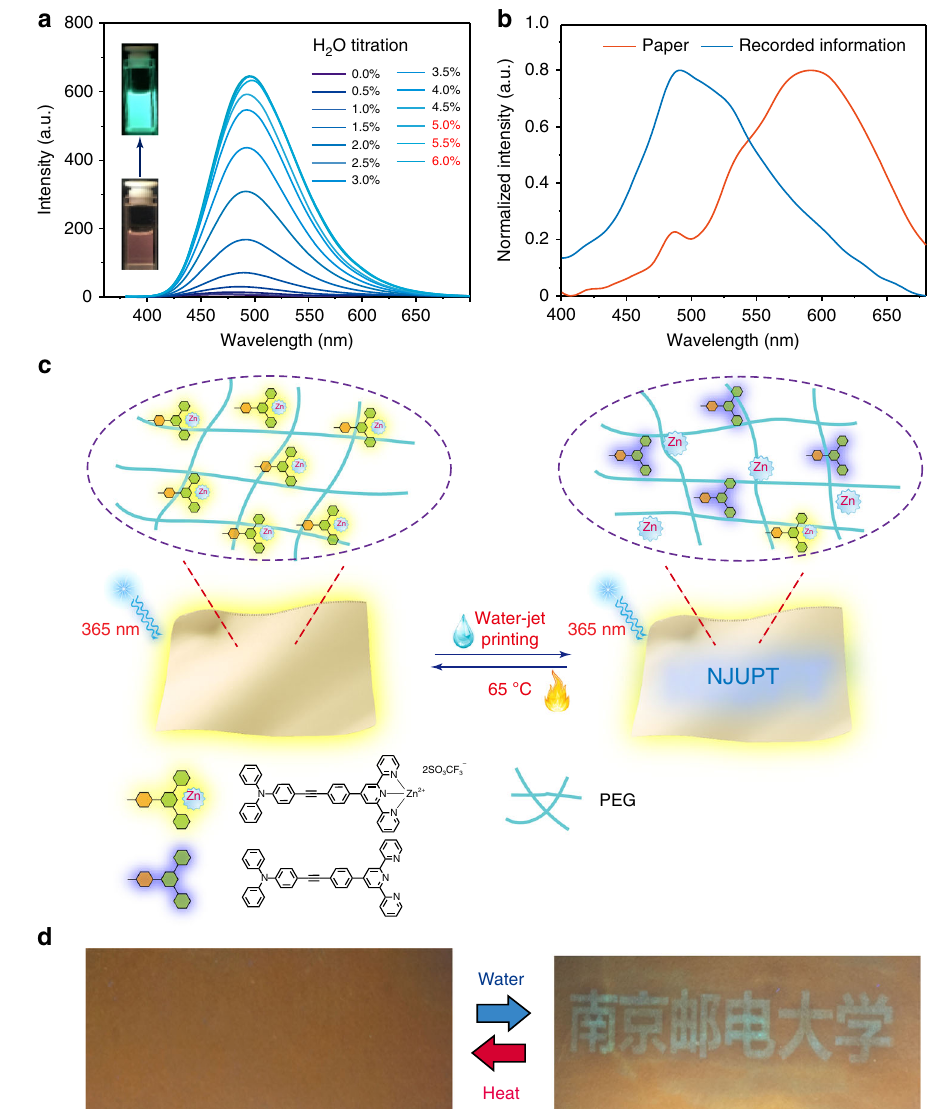
Fig. 5 Water-jet printing of rewritable paper. a PL spectra of complex L 3 -Zn in THF – water mixtures with different water fractions. b The emission spectra of L 3 -Zn before and after applying water on the rewritable paper. c Schematic illustrations of the writing and erasing processes of water-jet printing of rewritable paper based on L 3 -Zn . d Water-jet prints by a commercially available inkjet printer with cartridges re fi lled with water on the rewritable paper based on L 3 -Zn . Scale bar = 1